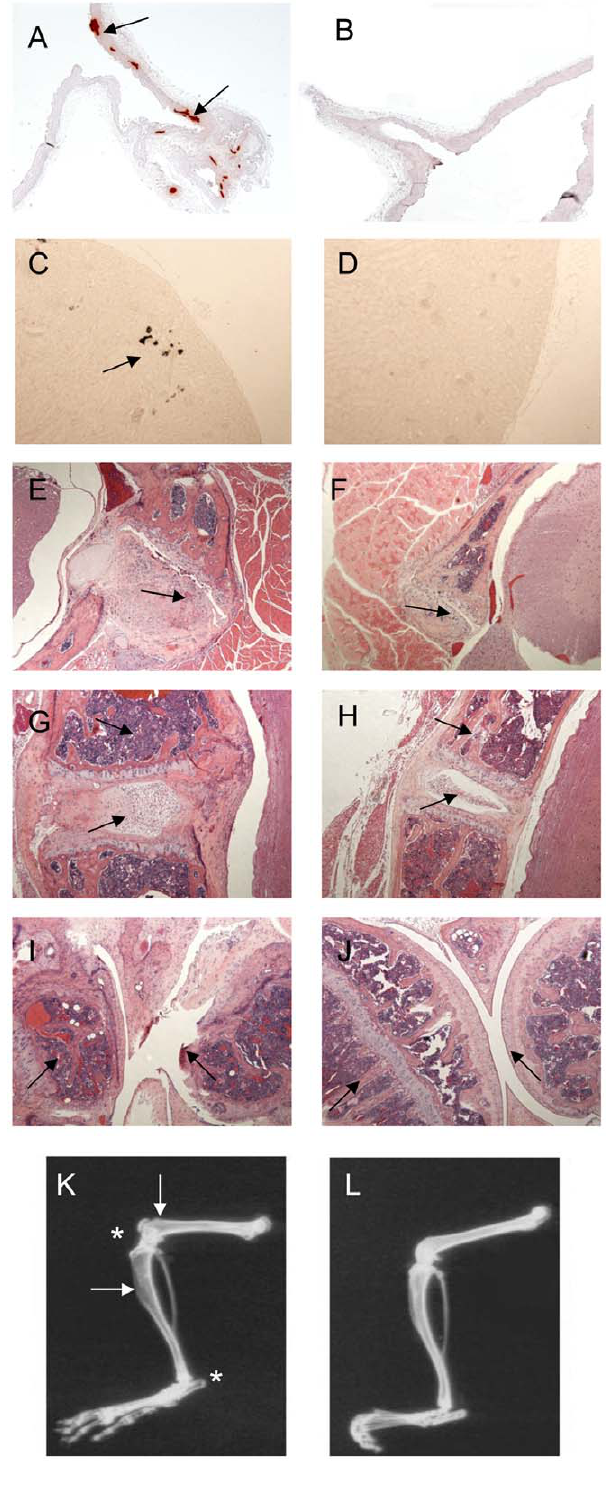
Figure 1. Histological and radiographic assessment of tissues from wild-type and Enpp1 2 / 2 mice. Calcification of the tunica media of the aorta was detected by alizarin red staining (arrows) in (A) Enpp1 2 / 2 compared to (B) wild-type control tissue. Ectopic calcification of the kidney was detected by von Kossa staining (arrow) in (C) Enpp1 2 / 2 compared to (D) wild-type control tissue. H&E stained transverse section of the neck of the (E) Enpp1 2 / 2 mouse showing an enlarged cervical vertebra and increased deposition of cartilage (arrows) compared to